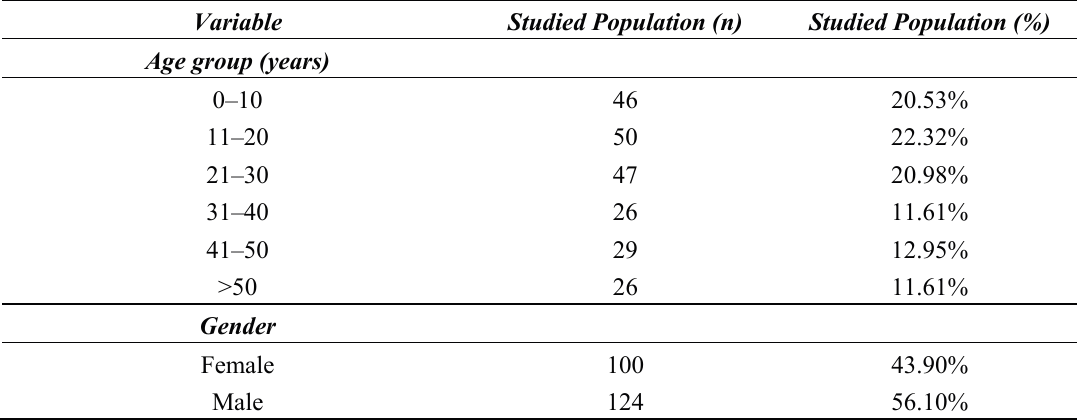
Table 1. Sociodemographic characteristics of the study subjects ( n =